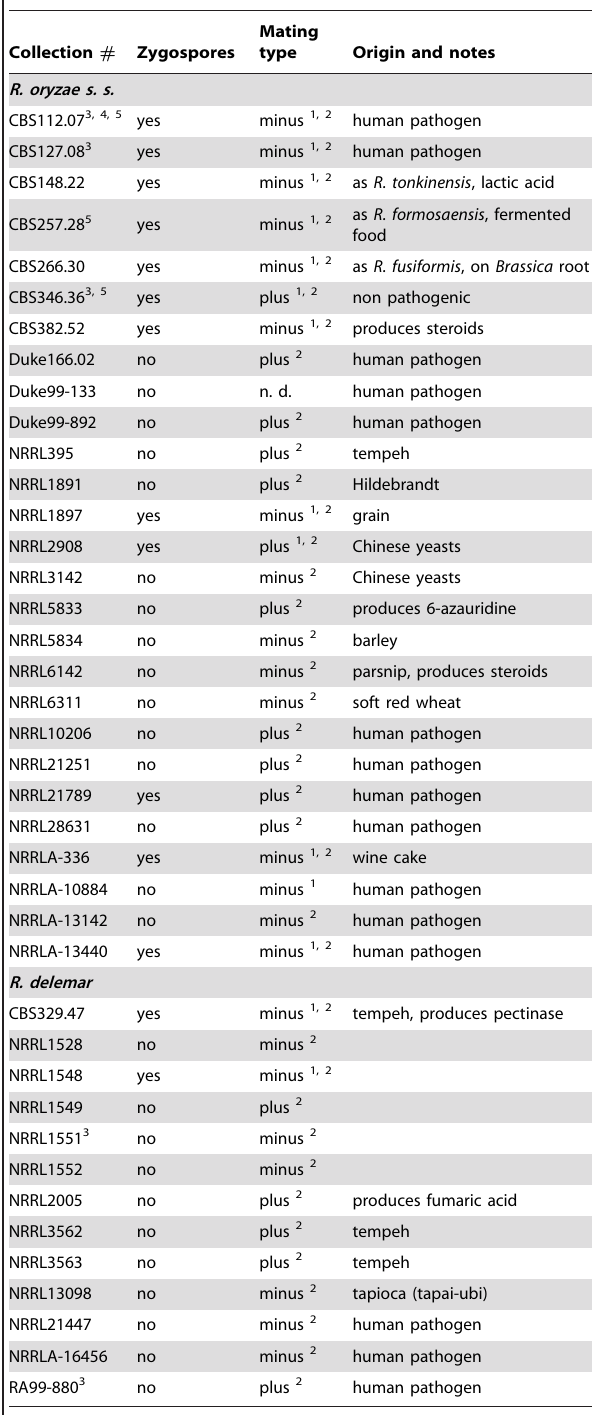
Table 1. Isolates of the Rhizopus oryzae complex used in this